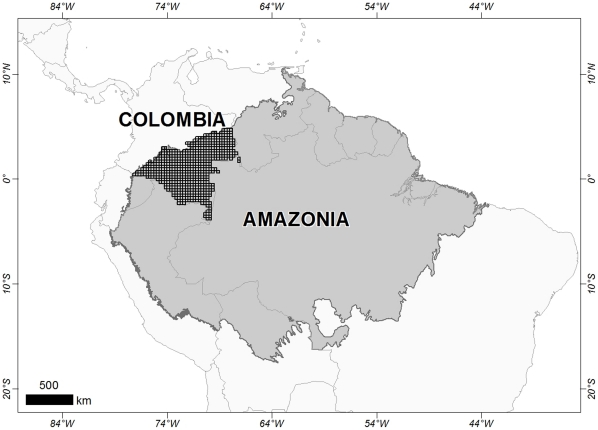
Map of the study area that depicts the limits of Amazonia and the Colombian part of the basin covered in this study.